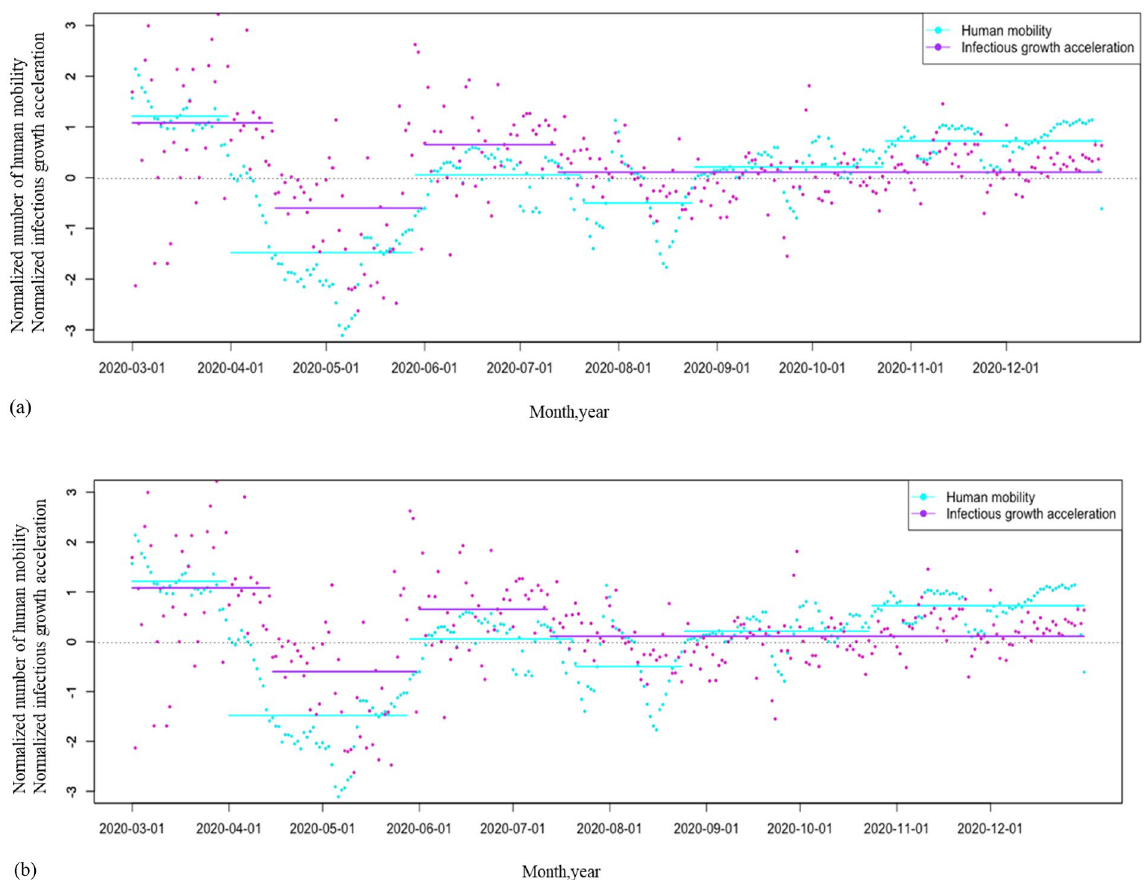
Figure 1. Plot of intra-human-mobility and infectious growth acceleration 2020/3/1 ~ 2020/12/12 in Tokyo, and means of each period given by change point detection. The dotted line is the threshold of infectious growth acceleration. ( a ) Infectious status is determined by the confirmed cases (PCR positive). ( b ) Infectious status is determined by the symptomatic cases. LocationMind xPop © LocationMind Inc.